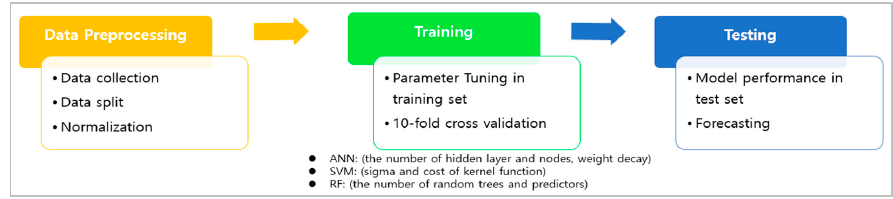
Figure 2. Modeling process for the machine learning models used.